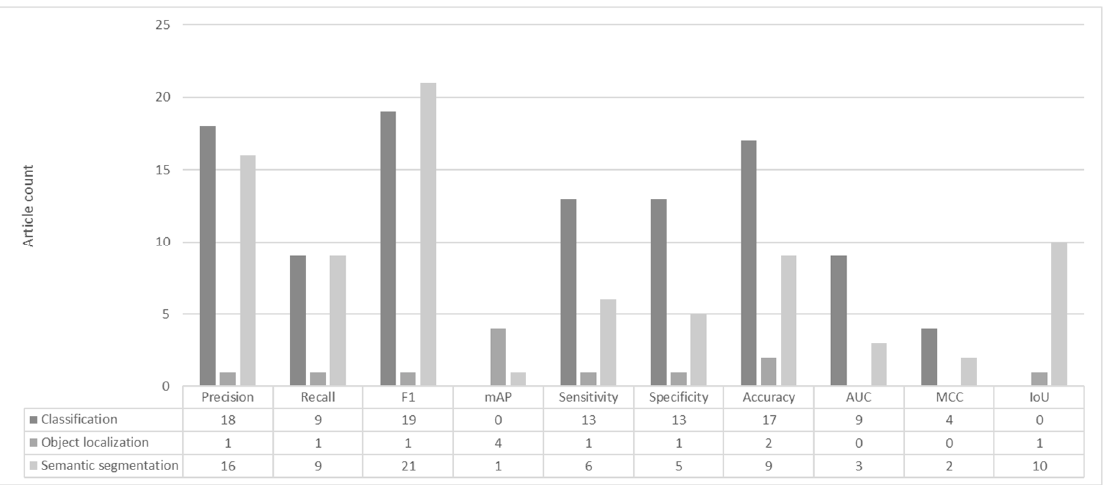
Figure 3. Usage counts of performance metrics.